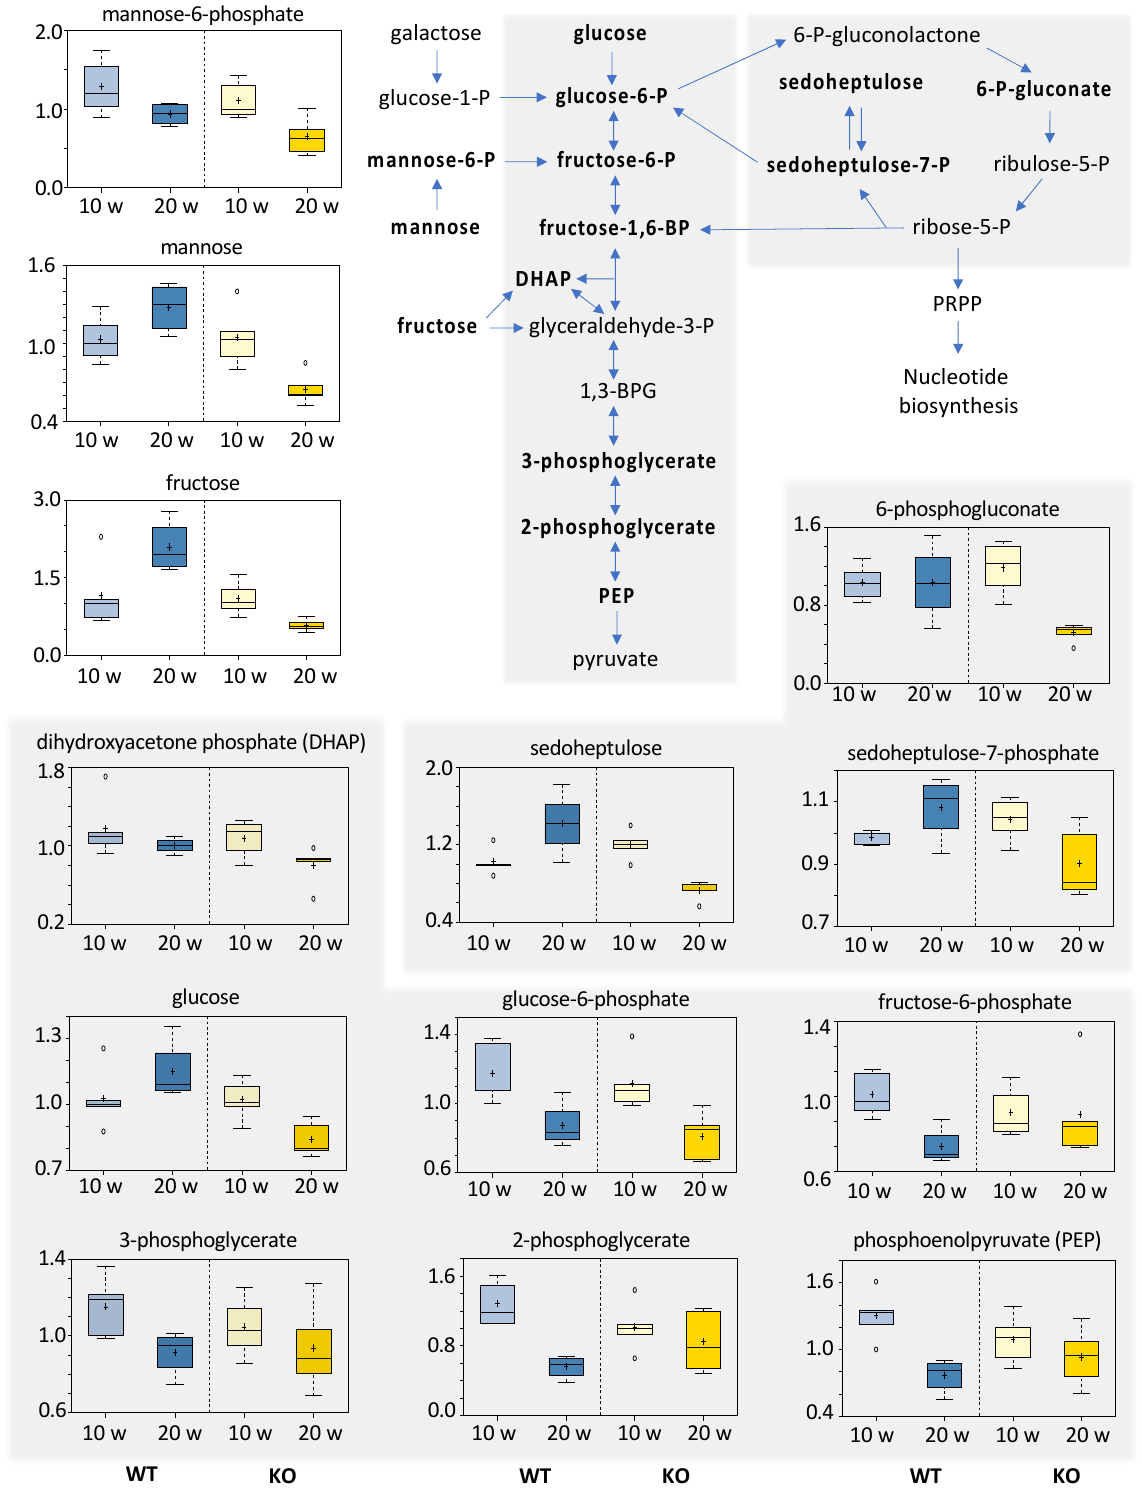
Figure 8. Effect of DEN on carbohydrates in WT and Aldh1l1 KO mice. Diagram schematically depicts glycolysis (highlighted in pink ) and the pentose phosphate pathway (highlighted in light green ). Metabolites identified by metabolomics are shown in boldface in the diagram. Y -axes of individual metabolite box plots represent scaled intensity. Measurements for each biochemical in the original scale were rescaled to set the median equal to 1.